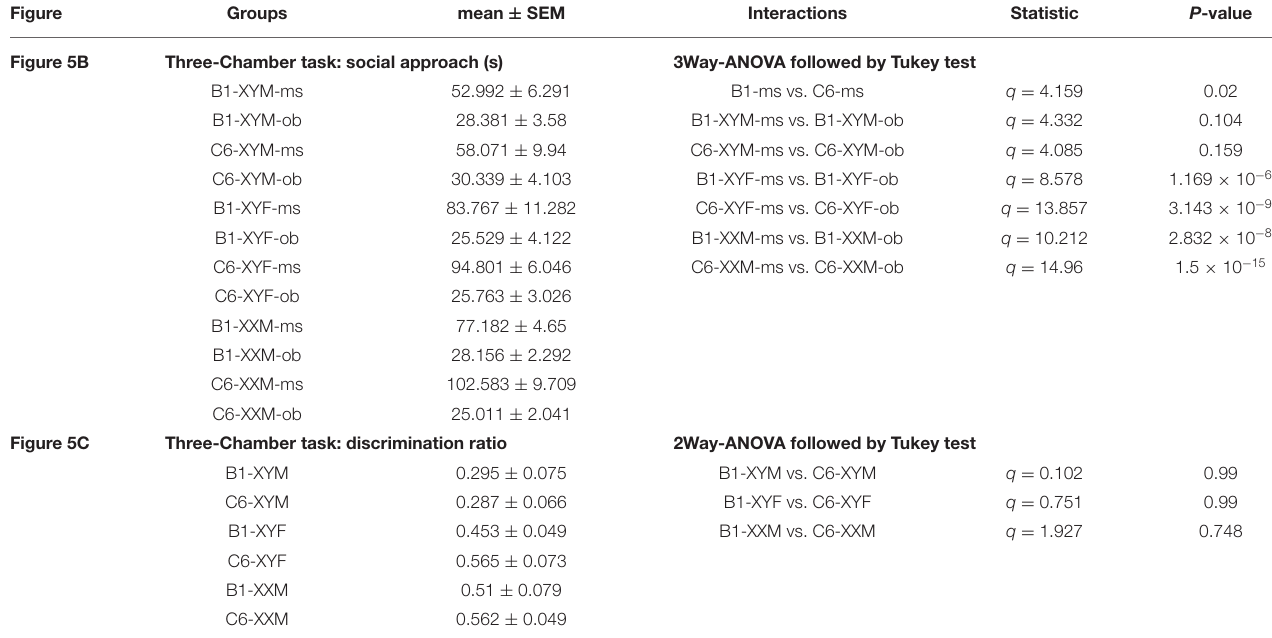
Three-Chamber task: social approach (s)